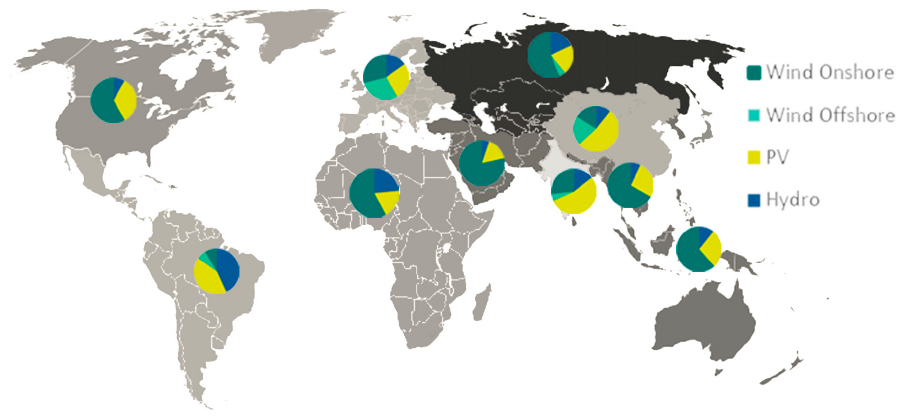
Figure 6. Power generation profiles in 2050.